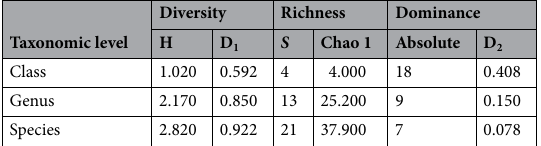
Table 2. Diversity indices for the hydrocarbonoclastic fungal